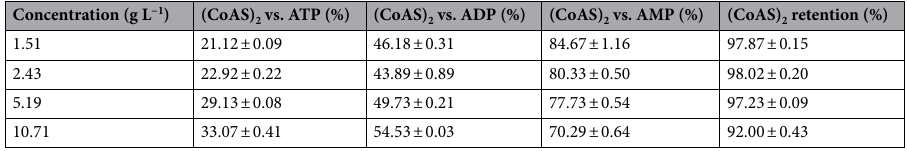
Table 1. Discrimination profile and (CoAS) 2 losses at 4 bars.